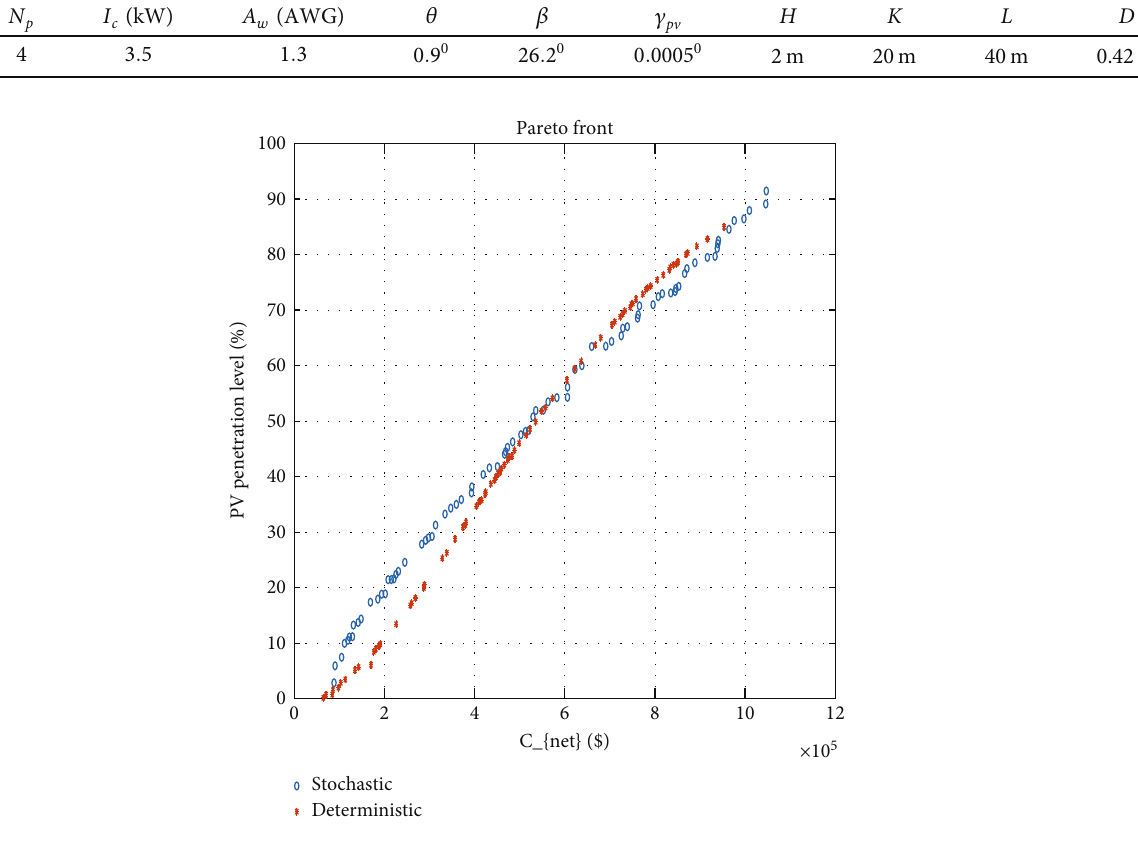
Figure 22: Comparison of stochastic and deterministic solutions.